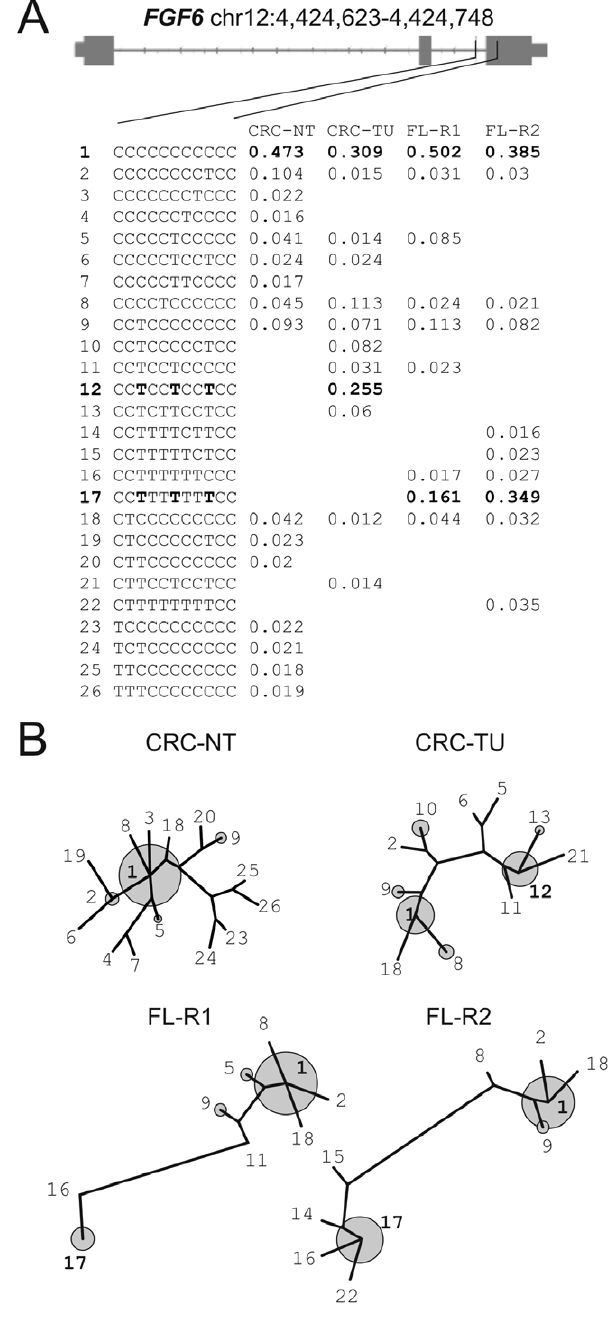
Figure 6. Hepitype diversity at the FGF6 (fibroblast growth factor 6) locus on chromosome 12 (4,424,623–4,424,748 bp) is characterized by progressive demethylation in tumors. In panel A, the hepitype frequencies in the four samples and an overview of the locus structure is given. Panel B shows maximum-parsimony trees constructed from hepitypes with a minimum frequency of 1%. The numbered hepitypes from panel A are annotated inthe trees. Thefrequent hepitypes are indicated by grey circles sized according to the relative frequencies. Trees have been constructed separately and branch lengths are thus nottoscale. Itis evident,thatbothincomparisonbetweennormal tissue and tumor in the colon cancer sample (CRC-NT, CRC-TU) and in comparison between the follicular lymphoma and it’s recurrence (FL-R1, FL-R2), the locus is characterized by progressive demethylation. The consistently demethylated sites between the colon cancer and lymphoma between hepitypes 12 and 17 are marked in bold print.